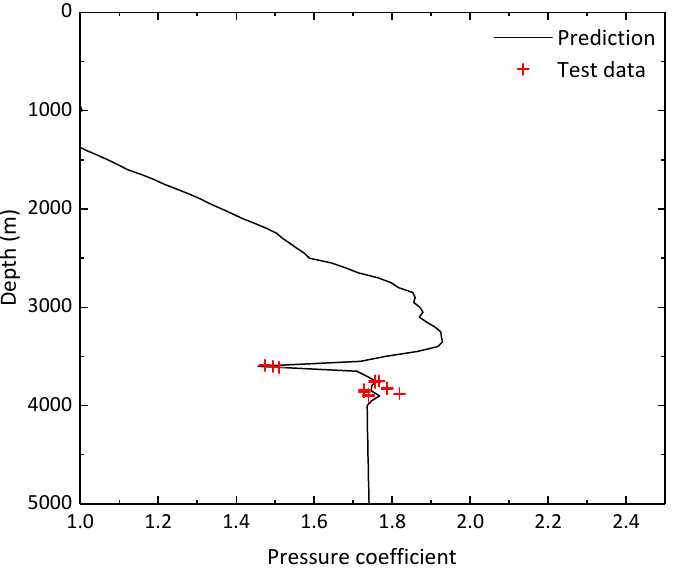
Figure 7. Comparison and verification of measured and predicted pressure of well X-3 .